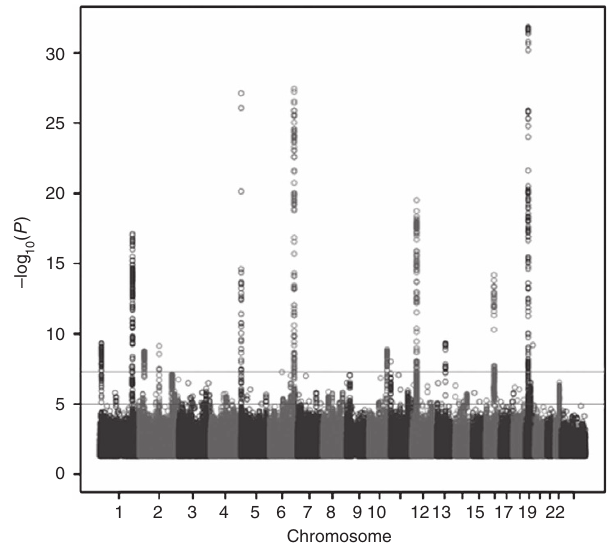
Figure 1 | Manhattan plot of ER-negative breast cancer meta-analysis. The Manhattan plot displays the strength of genetic association ( (cid:3) log 10 P ) versus chromosomal position (Mb), where each dot presents a genotyped or imputed (black circle) SNP. The black horizontal line represents the threshold for genome-wide significance ( P ¼ 5 (cid:2) 10 (cid:3) 8